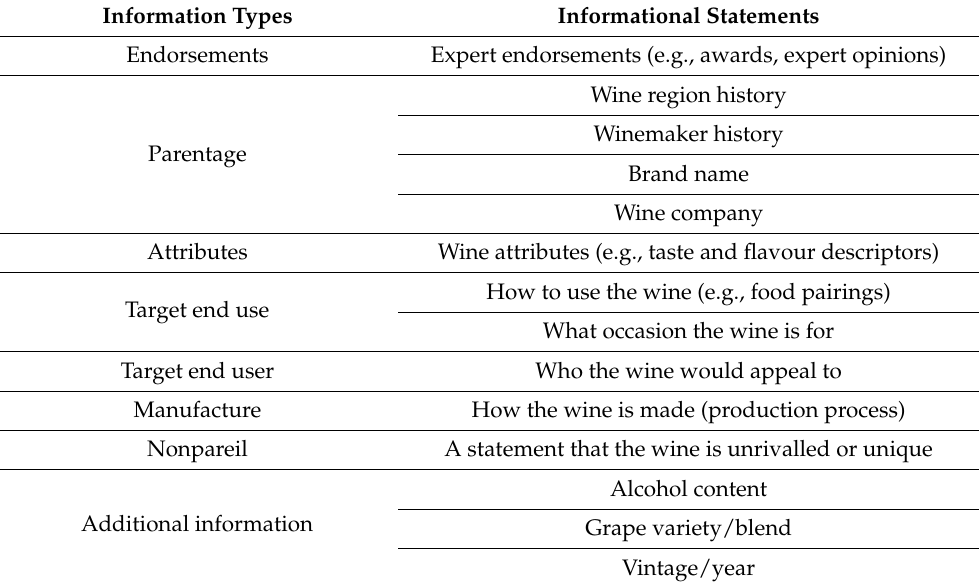
Table 1. Label information elements rated by respondents for importance when purchasing sparkling